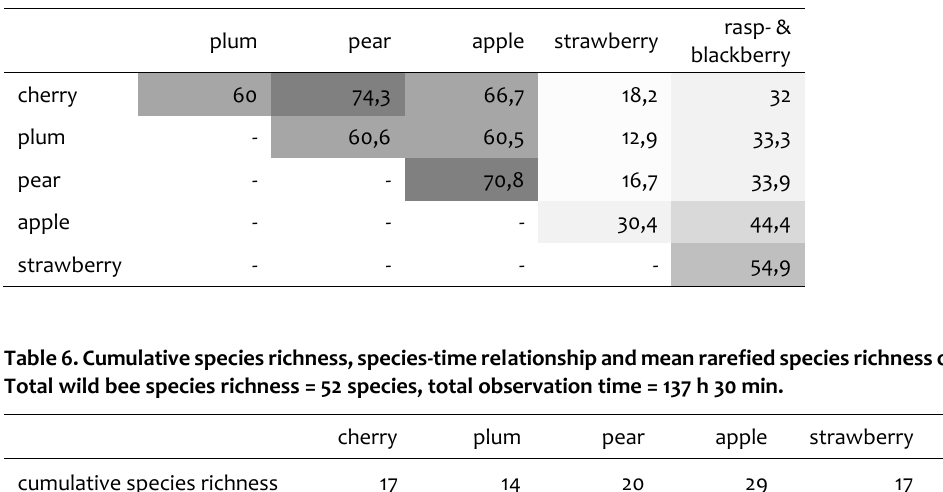
Table 5. Sörensen index accounting for the similarity between wild bee communities of each crop. Darkening shades of grey indicate increasing similarity between plant species.